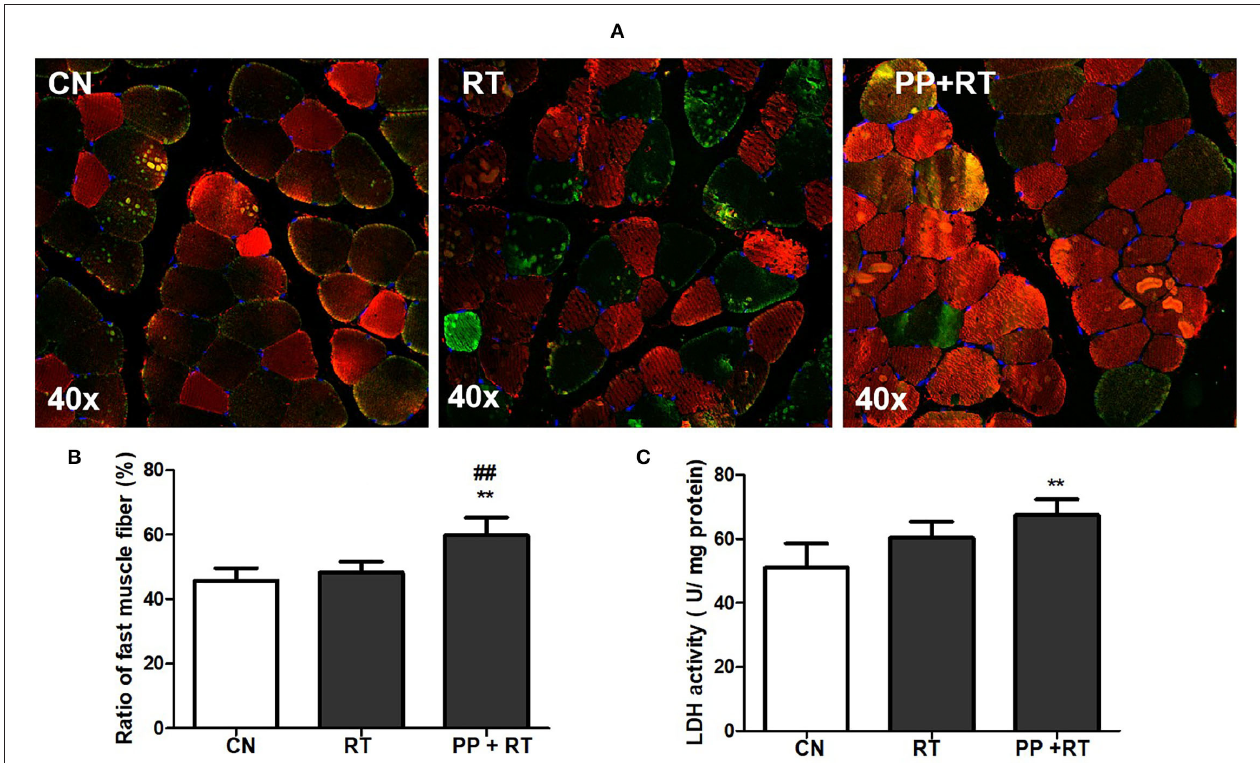
FIGURE 3 | Pea peptide supplementation enhanced the proportion of type 2 muscle fiber. (A) Immunofluorescence staining of biceps brachii in the rats of CN, RT, PP + RT group (40 x). Fast muscle fibers were labeled with red fluorescence and slow muscle fibers were labeled with green fluorescence; (B) statistical analysis of (A) ; (C) upper limb grip of rats in CN, RT, PP + RT group. CN: Control group; RT: resistance training group; PP + RT: pea peptide supplementation combined with resistance training. The significant difference between groups was validated with one-way ANOVA using GraphPad Prism 6, ** p < 0.01 vs. CN group, and ## p < 0.01 vs. RT group ( n = 5/group). Data are presented as mean ± standard deviation (M ±